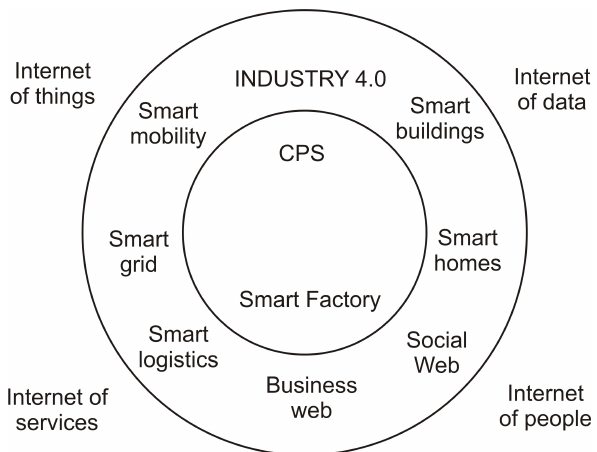
Figure 1: The Industry 4.0 environment, adapted from